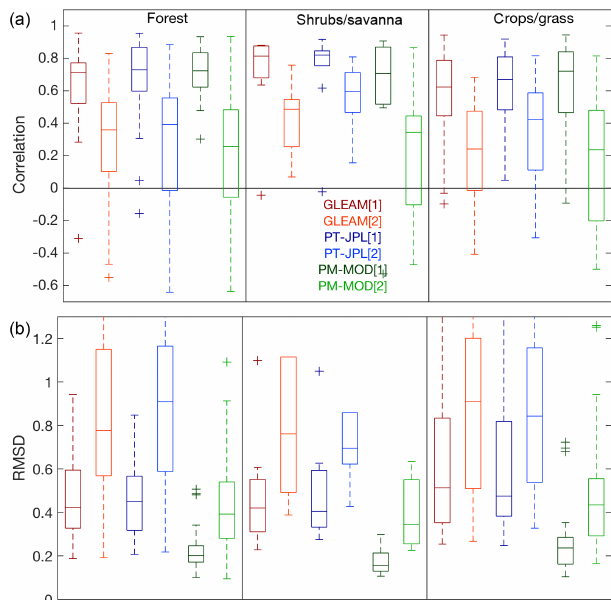
Figure 12. Box plot showing for the three land cover groups the correlation (a) and RMSD (b) between the station local weights and the weights predicted by the NN for the two tests presented in Sect. 7.3 (first test labelled as [1] in legend, dark colours, second test as [2], light colours). See the text for details.